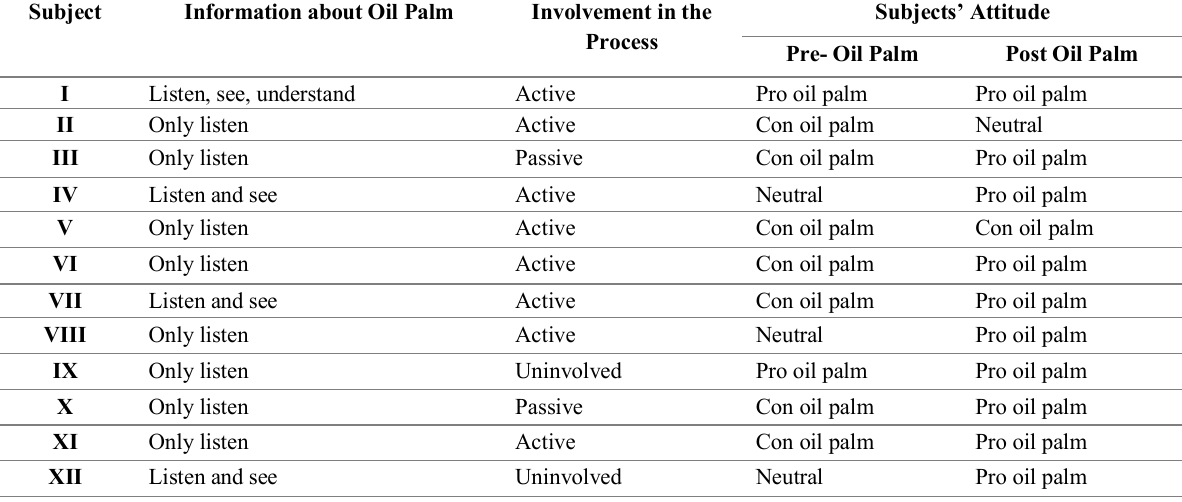
Table 2. Subjects’s Knowledge about Oil Palm, Involvement and Attitude Pre- and Post- Oil Palm Investment